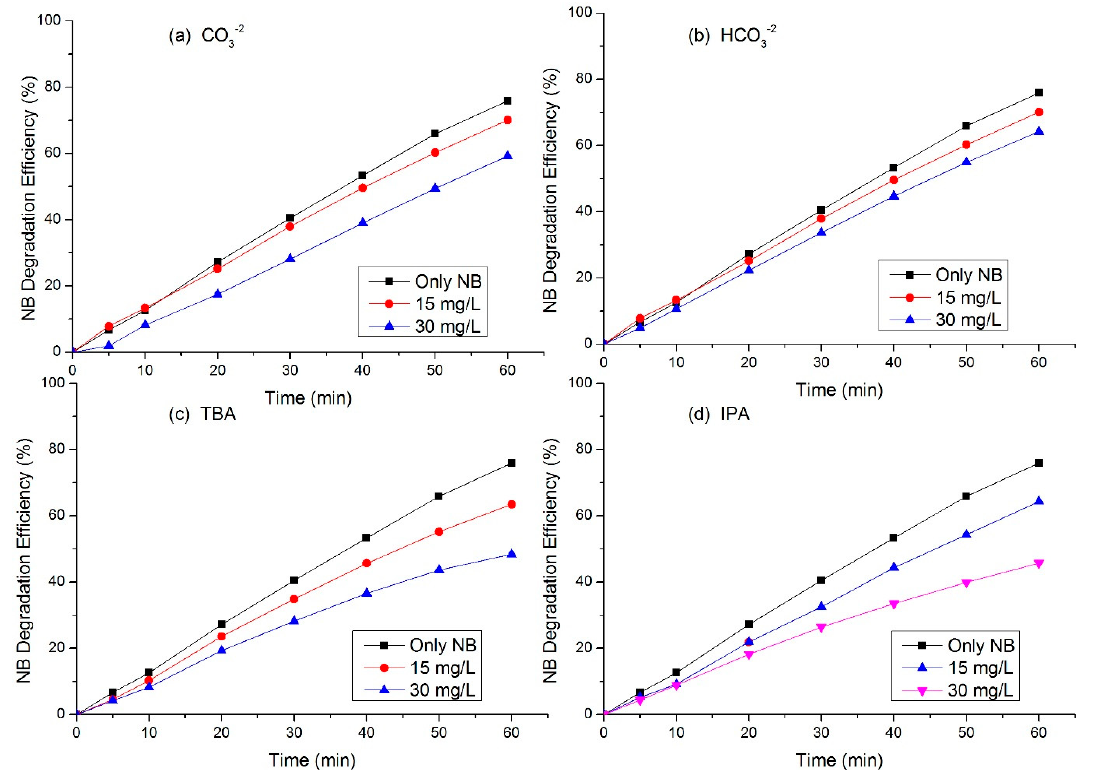
Figure 7. The effect of different hydroxyl radical scavengers on the degradation of NB, at an NB concentration of 20 mg/L, an oxygen flow rate of 3 L/min, and an applied voltage of 1.8 kV. ( a ) Effect concentration of 20 mg / L, an oxygen flow rate of 3 L / min, and an applied voltage of 1.8 kV. ( a ) E ff ect of of carbonate ions; ( b ) Effect of bicarbonate ions; ( c ) Effect of tertiary butyl alcohol (TBA) and ( d ) Effect carbonate ions; ( b ) E ff ect of bicarbonate ions; ( c ) E ff ect of tertiary butyl alcohol (TBA) and ( d ) E ff ect of of isopropyl alcohol (IPA). isopropyl alcohol